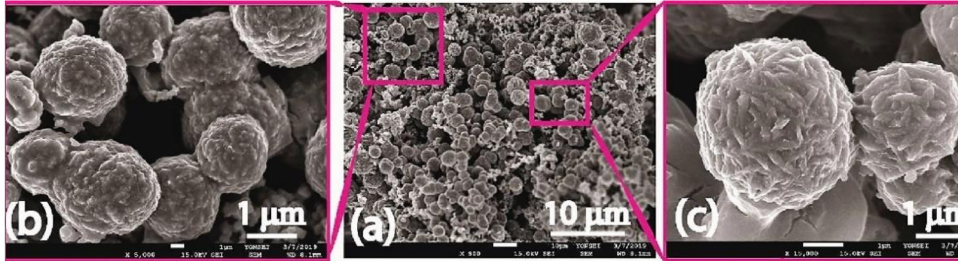
Figure 9. FE-SEM images of globular flower-shaped NiS at magnifications of ( a ) 10 µ m and ( b , c ) 1 µ m. Adapted with permission from [205]. Copyright 2019,